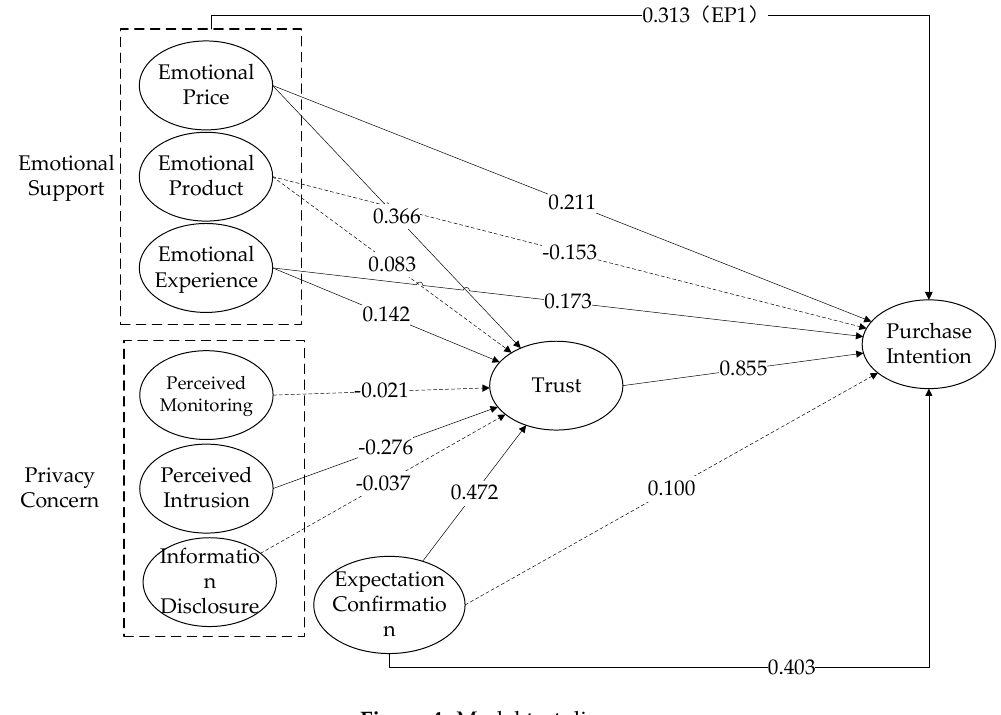
Figure 4. Model test diagram.